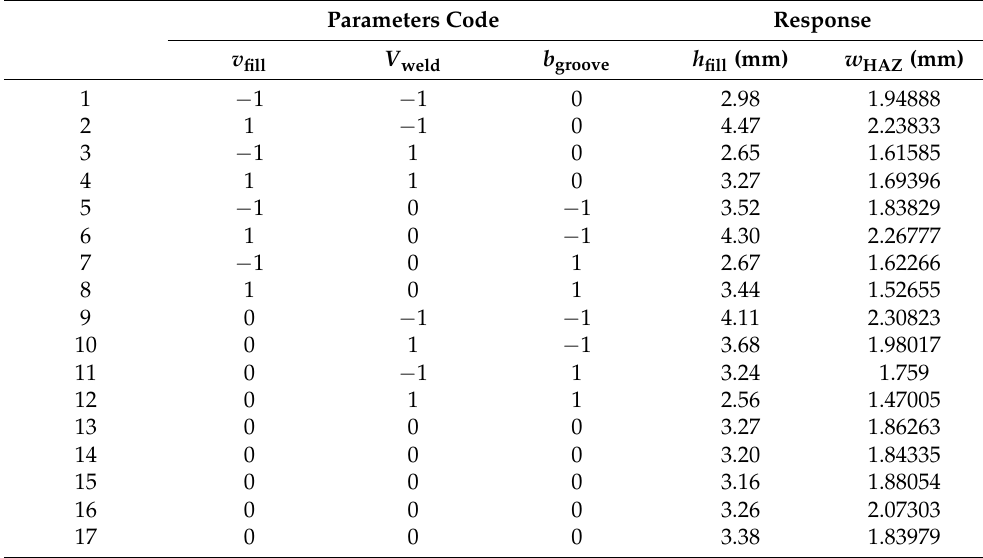
Table 4. Experimental parameters and responses in the Box–Behnken design.